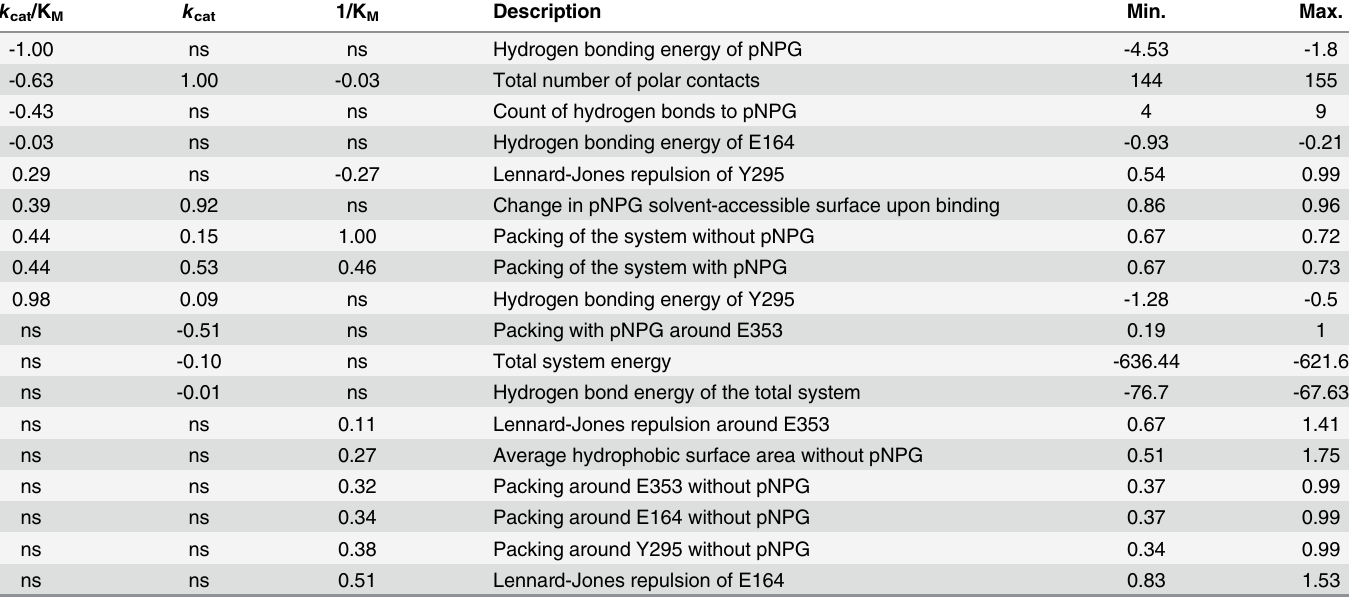
Table 1. Most informative structural features predicting each kinetic constant. For each mutant, 10 out of 100 models were selected based on the low- est total system energy. Fifty-nine structural features were calculated for the selected models and the most informative features were selected based on a constrained regularization technique (elastic net with bagging; see Methods). The table contains features that have been assigned non-zero weights during training (9 for k cat /K M , 8 for k cat , 10 for K M ). The weights are multiplied by a normalized form of the value (not shown), and can therefore indicate both a positive or negative relationship. For example, a negative weight for hydrogen bonding is consistent with a positive correlation to hydrogen bonding where a smaller number indicates more hydrogen bonding is occurring. Inversely, a positive weight for packing would indicate a positive correlation since a larger value indi- cates a system with fewer voids. The relative contribution of each feature in determining the kinetic constant is given as a normalized weight (columns 1 – 3). Column 4 provides a description of each feature, and columns 5 and 6 show the range of observed values in the training dataset. The full feature table is avail- able in S2 Table. ns = feature not selected by the algorithm